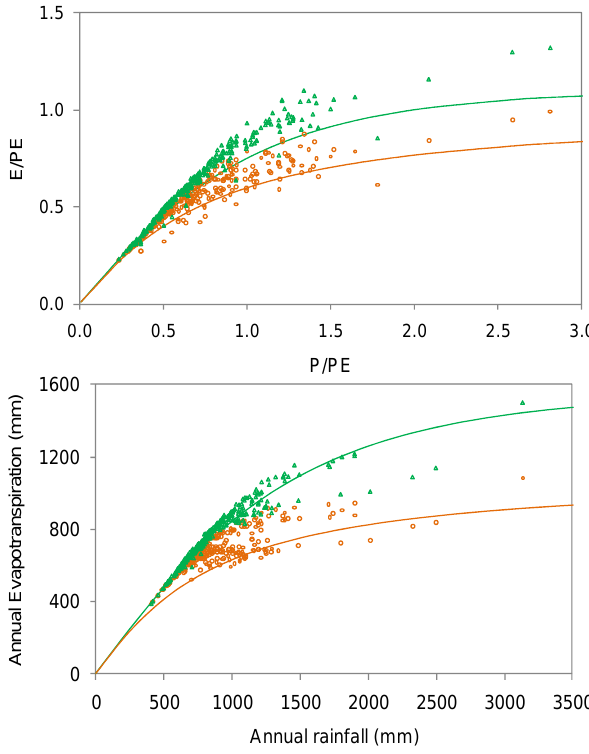
Fig. 2. Comparison of AWRA-L simulated mean streamflow for the 278 catchments for scenarios of forest cover (green triangles) and herbaceous cover (orange circles) shown in two different ways. Also shown are the two models proposed by Zhang et al. (2001): (top panel) Zhang-A and (bottom panel)